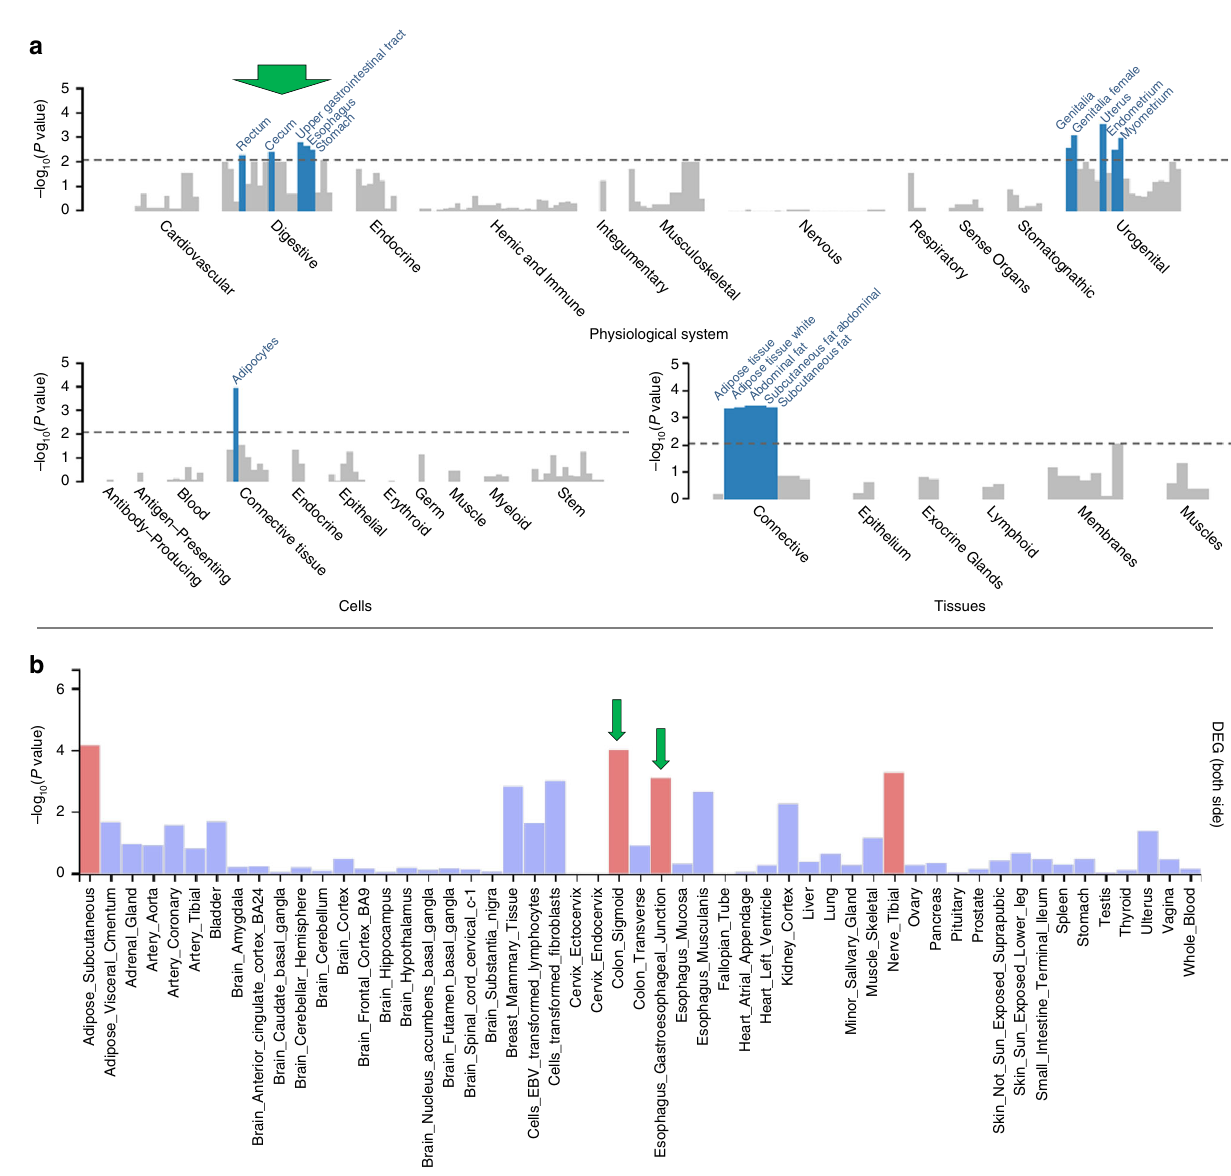
Fig. 6 Tissue-speci fi c gene expression for WHRonly − variants. Shown are results of DEPICT and FUMA tissue-speci fi city analyses based on variants that were selected from GWAS-only meta-analyses of GIANT ( P < 10 − 5 ) and that were classi fi ed as WHRonly − . Signi fi cant results within the digestive system are marked with green arrows . a DEPICT results for WHRonly − with signi fi cant enrichments highlighted in blue (FDR < 5%). Results are grouped by type and ordered alphabetically by MeSH term within a speci fi c system, cell type, or tissue (details in Supplementary Data 9). Results for the other three classes showed no signi fi cance with DEPICT (Supplementary Figure 6). b FUMA results with signi fi cant enrichments highlighted in red (adjusted P < 0.05, Bonferroni-corrected, details in Supplementary Data 13). The -log10( P values) in the graph refer to the probability of the hypergeomteric test. Results for the other three classes showed only little enrichment with FUMA (Supplementary Figure